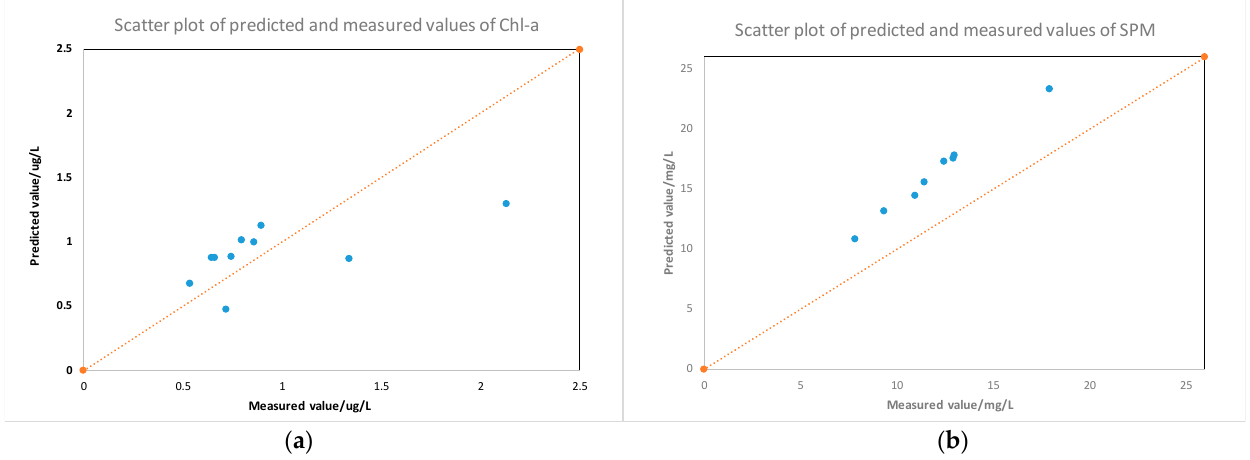
Figure 9. Image sampling point inversion value and measured value scatter plot: ( a ) Chlorophyll a; ( b ) SPM.